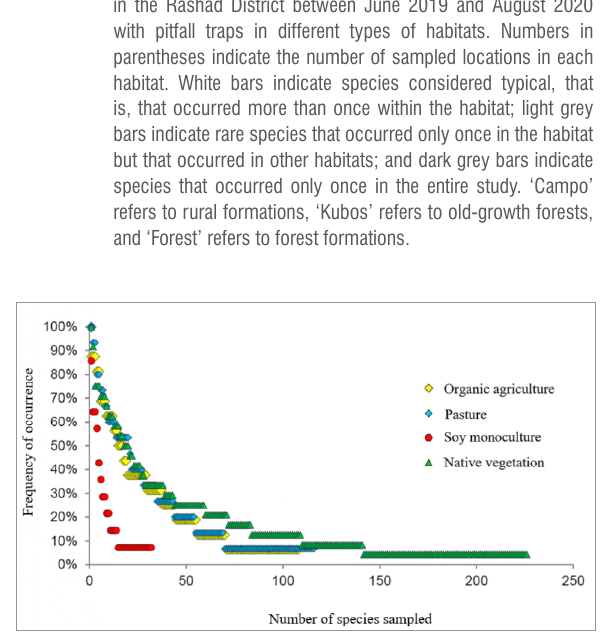
Figure 7: Frequency of occurrence of species collected in the Rashad District between June 2019 and August 2020 using pitfall traps in different habitat types. The species were ordered in descending order, according to their frequency of occurrence in the 69 sampled